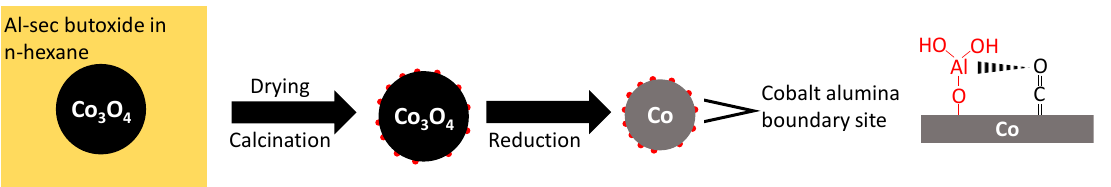
Figure 6. Schematic depiction of the formation of sub-nanometer-sized alumina islands upon impregnating a cobalt oxide surface with Al-sec butoxide in n-hexane, and their interaction with CO adsorbed on the reduced metal surface.